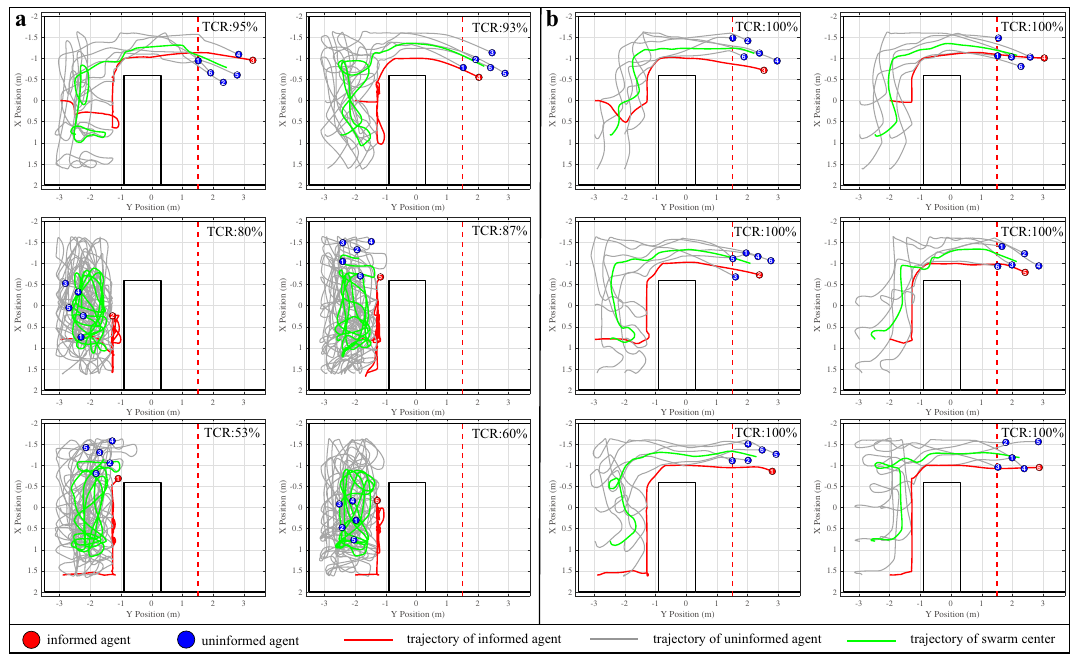
Fig. 7 Simulation diagram of the flight trajectory of the drone swarm when the informed agent is in different initial positions. a Simulation results of the proposed flocking algorithm with non-AGDS. TCR is the